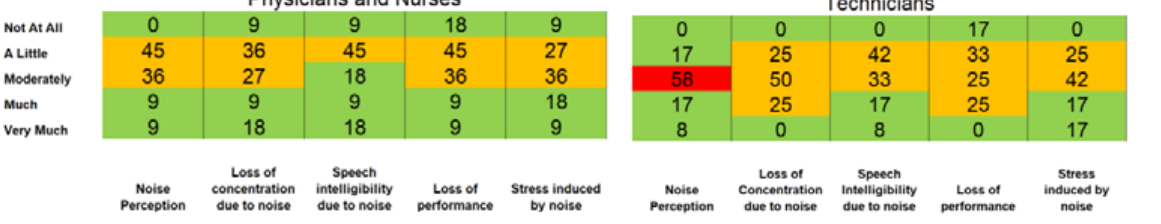
Figure 7. Interactions between the perceived noise and its extra-auditory effects reported by the staff members (occurrence percentage of responses